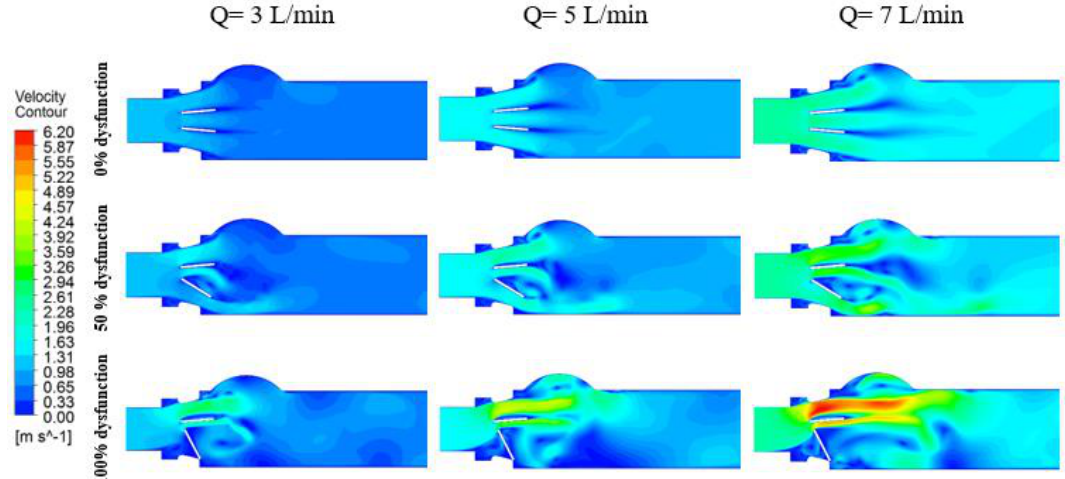
Figure 6. Velocity contours at peak systole (90 ms) for different percentages of BMHV dysfunction at three different cardiac outputs (3, 5 and 7 L/min) for 19 mm LVOT.